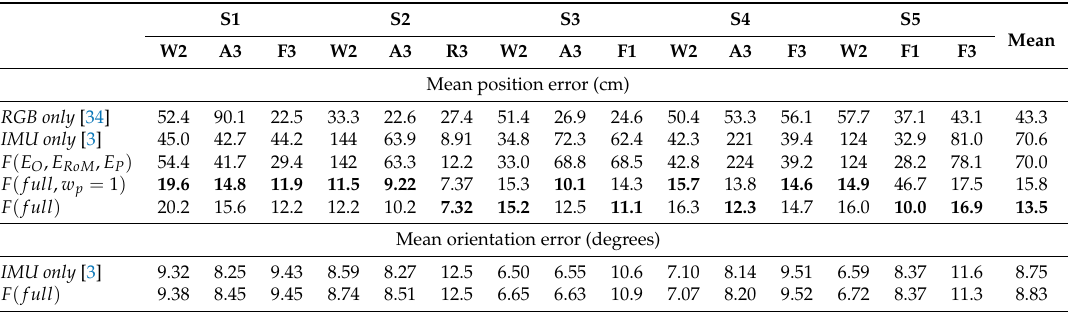
Table 1. 3D position error (cm) on TotalCapture